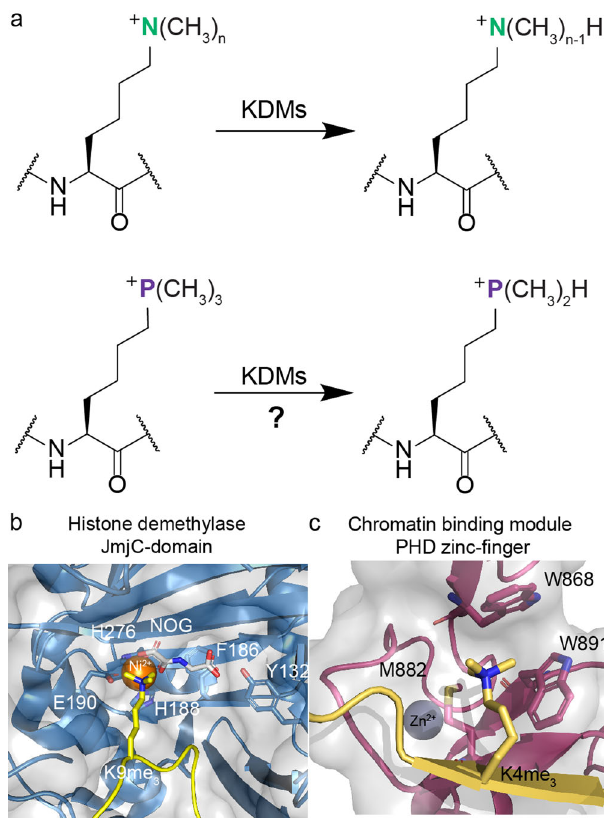
Fig. 1 Demethylation and recognition of N ε -methylated lysines by erasing enzymes and reader proteins. a JmjC KDMs catalyse demethylation of N ε - trimethyllysine residues. Our work explored recognition of the simplest positively charged N ε -trimethyllysine analogue, i.e., the trimethylphosphonium derivative, by N ε -methyllysine binding proteins and N ε -methyllysine demethylases. n: number of methyl groups (3 – 1). b View from a structure of a JmjC KDM (KDM4A JmjC , light blue) complexed with H3K9me 3 (yellow) and NOG (N-oxalylglycine, a 2OG analogue, white) (PDB: 2OQ6). c View from a structure of a reader (TAF3 PHD , purple) complexed with H3K4me 3 (yellow) (PDB: 2K17). Nitrogen: dark blue; oxygen: red; sulphur: yellow; zinc: grey; nickel: